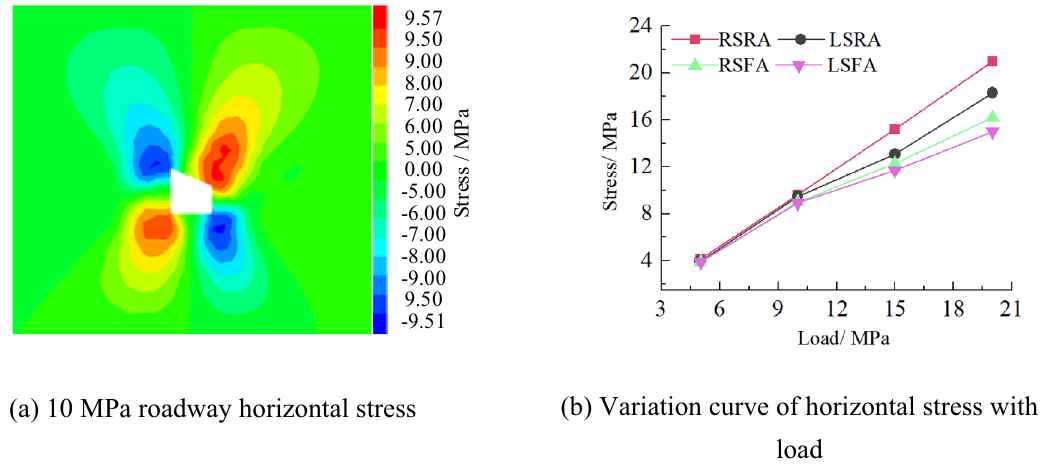
Figure 18. Horizontal stress distribution law of roadway.